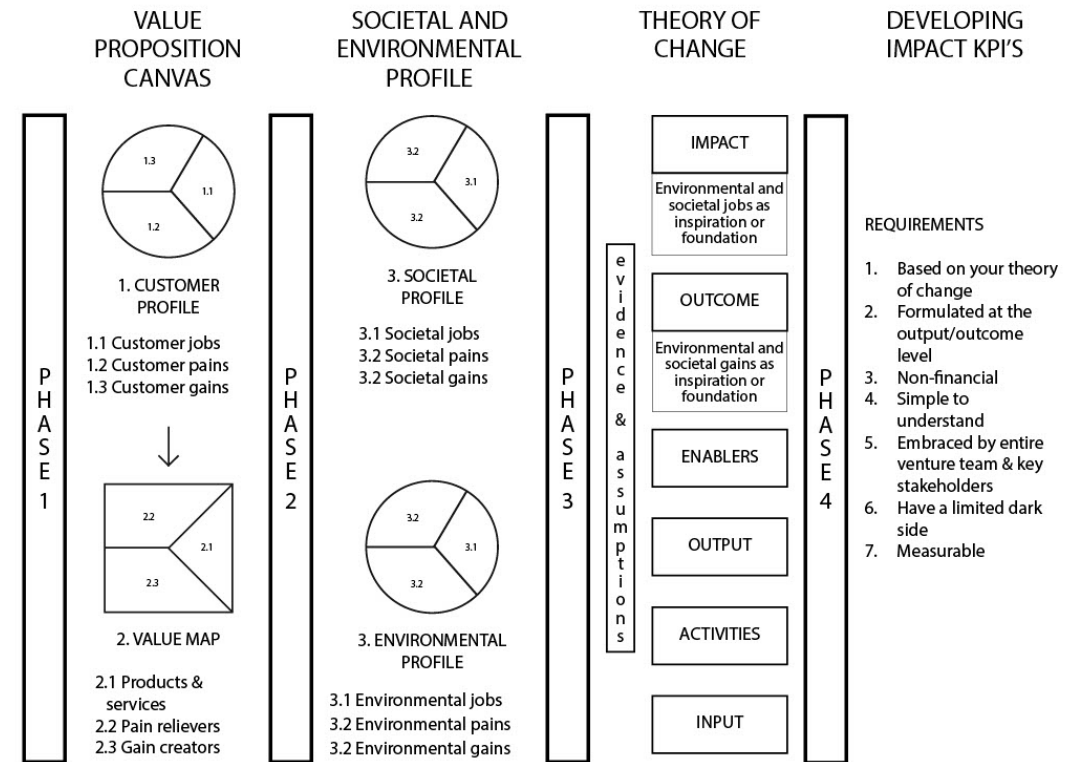
Figure 1. Overview of four phases of the Figure 1 . Overview of four phases of the tool.